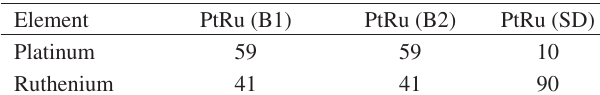
Table 1. Atomic ratios of Pt and Ru in the electrocatalysts.